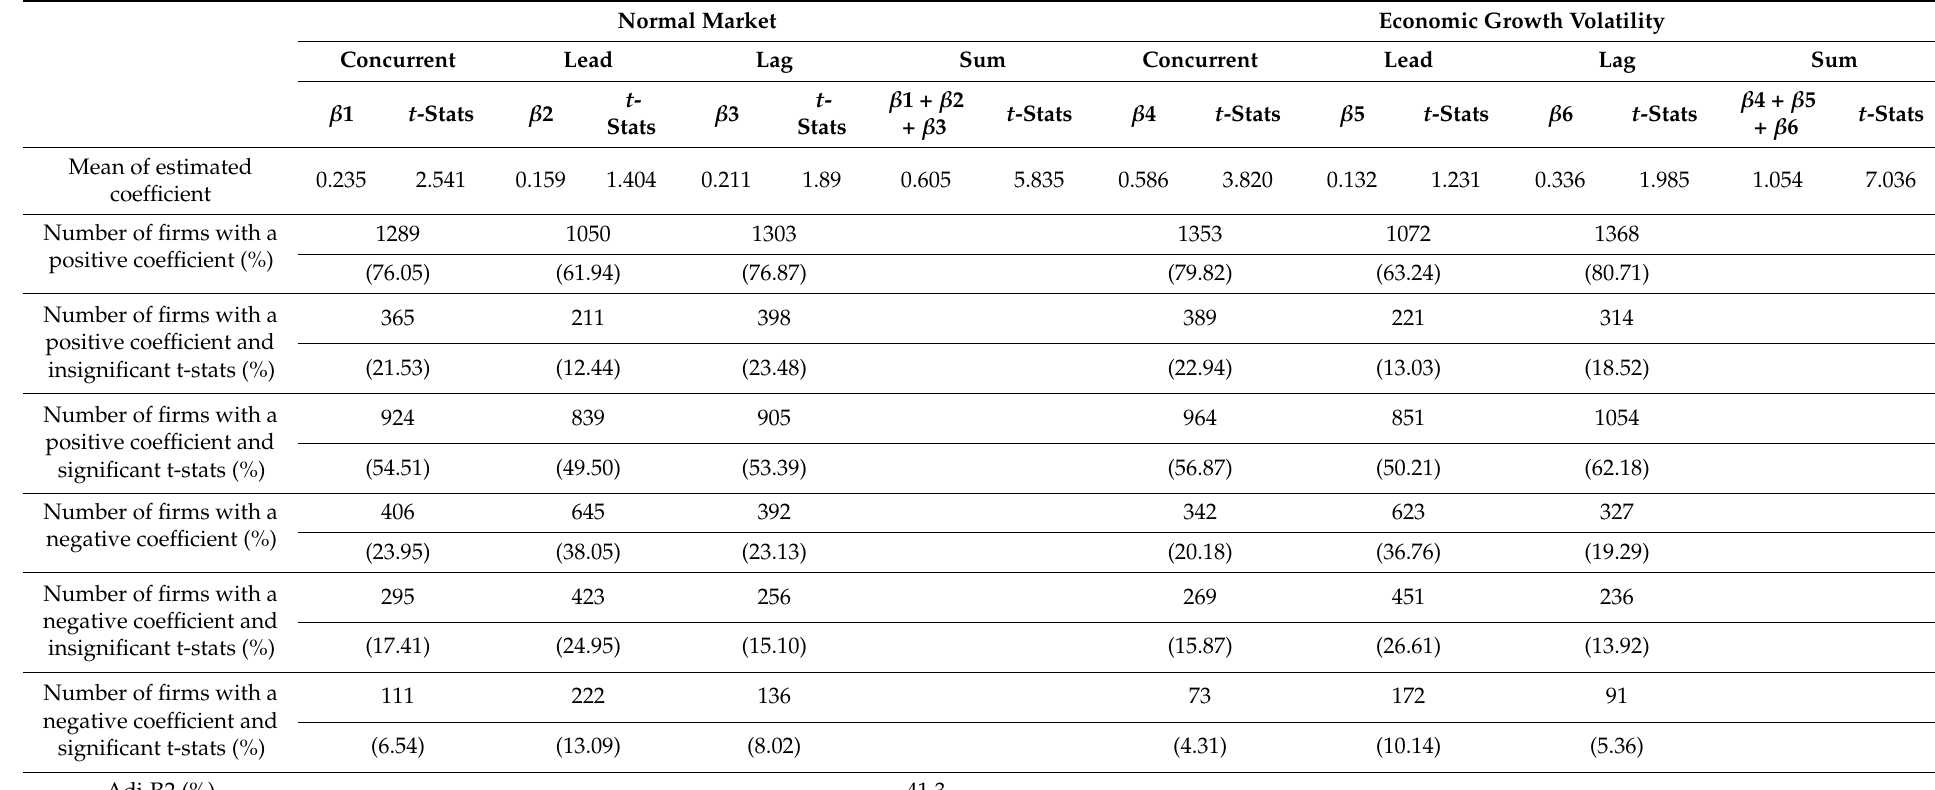
Table 6. Impact of economic growth volatility on liquidity